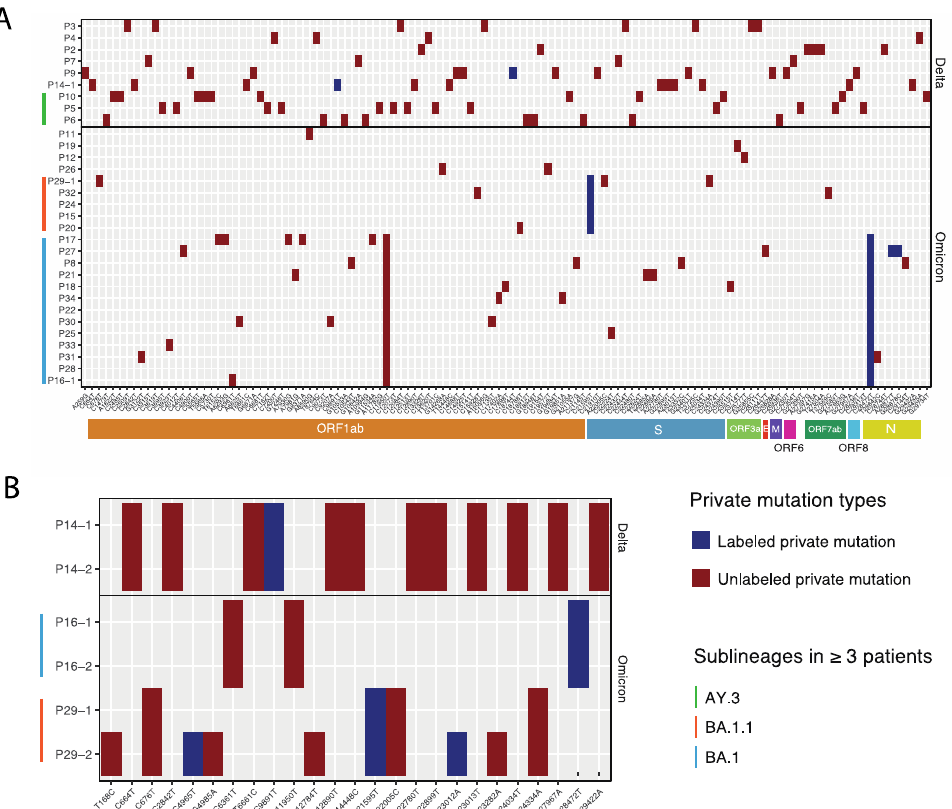
Figure 5. Private mutation patterns observed in Delta and Omicron variants infected patients. ( A ) Private mutations found in applicable Delta and Omicron patients ( n = 31). Y -axis shows the patient samples and X -axis shows the exact mutations with their corresponding gene position in the coding regions indicated at the bottom. ( B ) Private mutation patterns in three repeatedly sampled patients (P14, P16, and P29). For both ( A ) and ( B ), labeled and unlabeled private mutations (as identified by Nextclade) are shown in dark blue or dark red colors, respectively. Sublineages of Delta and Omicron identified in multiple patients (n ≥ 3) are indicated on the left of the Y -axis in different colors.